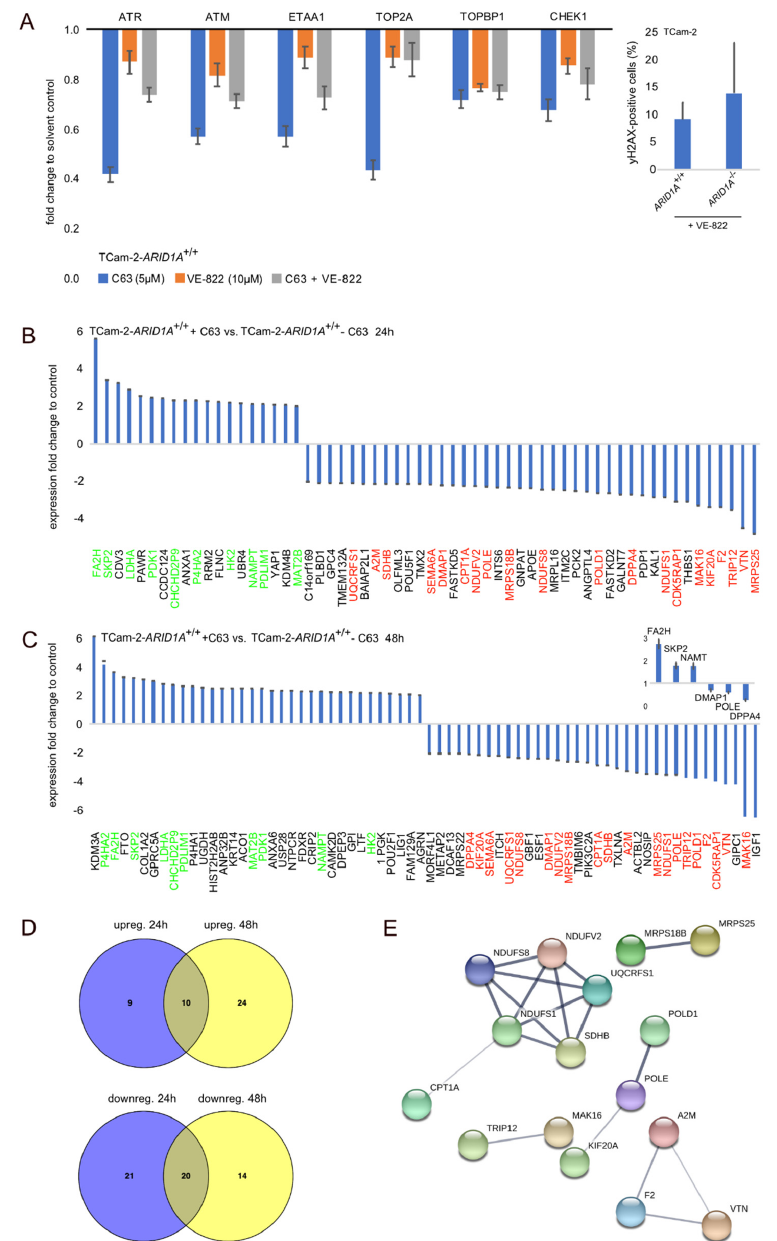
Figure 3. ( A ) qRT-PCR analysis of expression of ATR and DNA damage response associated factors in C63 (5 μ M) and VE-822 (10 μ M) treated TCam-2 cells. Inlay: Number of phospho- γ H2AX-positive cells after 10 μ M VE-822 treatment of TCam-2- ARID1A +/+ and - ARID1A − / − cells. ( B , C ) Mass spectrometry data of proteins enriched or depleted in TCam-2 cells treated for 24 (B) and 48 h ( C ) with C63. A qRT-PCR analysis confirmed upregulation of FA2H, SKP2 and NAMT as well as downregulation of DMAP1 , POLE and DPPA4 (C, inlay). ( D ) Venn diagram summarizing commonly enriched or depleted proteins in TCam-2 cells treated for 24 and 48 h with C63. (E) STRING-based interaction prediction of proteins commonly depleted in C63 treated TCam-2 (24 + 48 h).